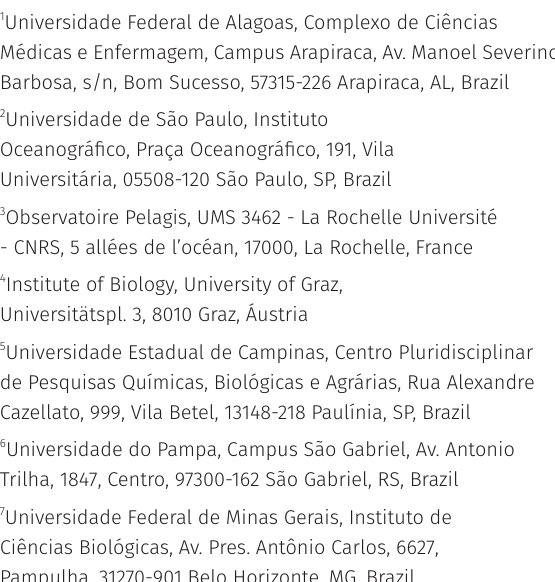
Figure S1. Tables SI,